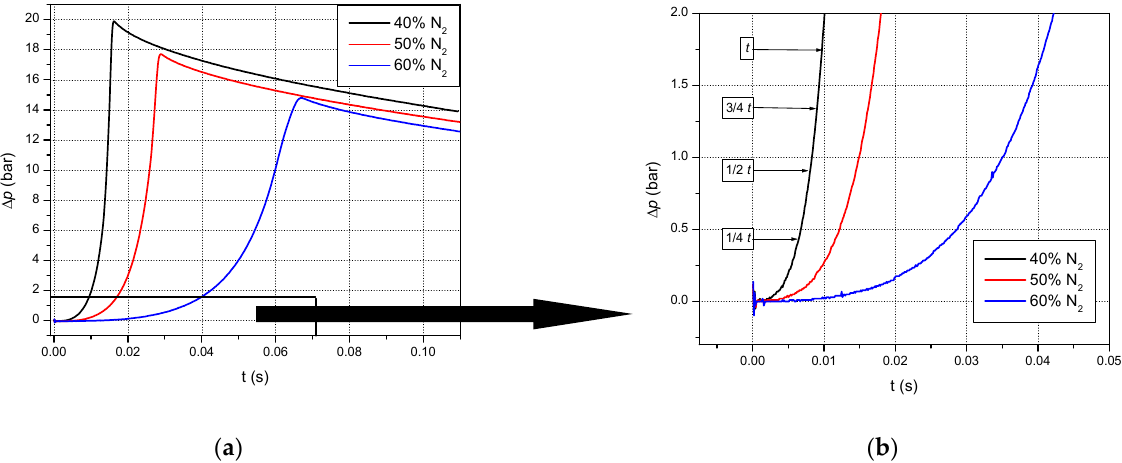
Figure 4. Pressure variation during the explosions in stoichiometric CH 4 -N 2 O mixtures diluted with N 2 , at p 0 = 1.75 bar and ambient initial temperature. ( a ) the whole p( t ) curve; ( b ) a magnified diagram representing the incipient period of the flame propagation.